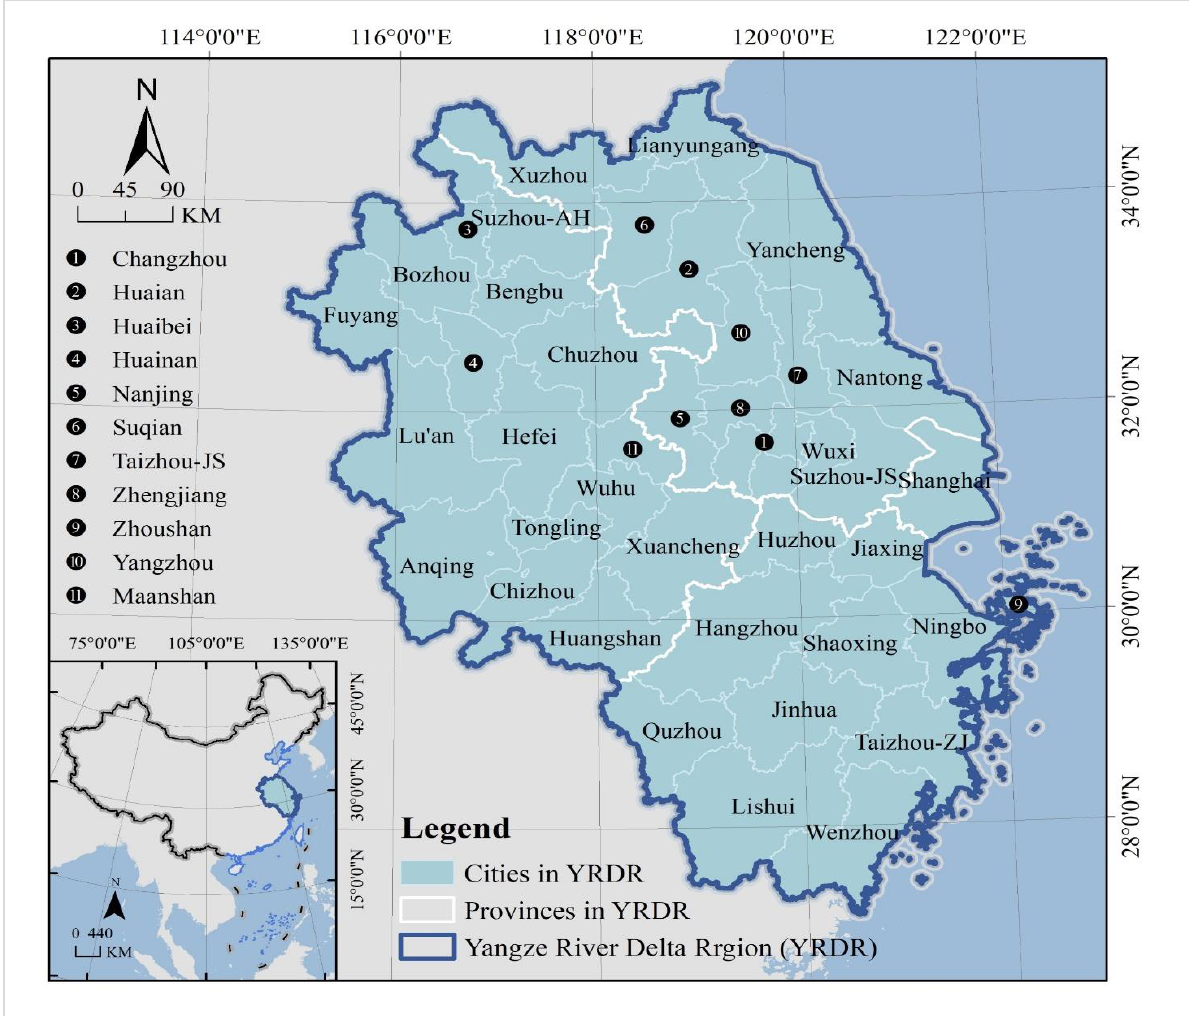
Figure 1. Study Area.